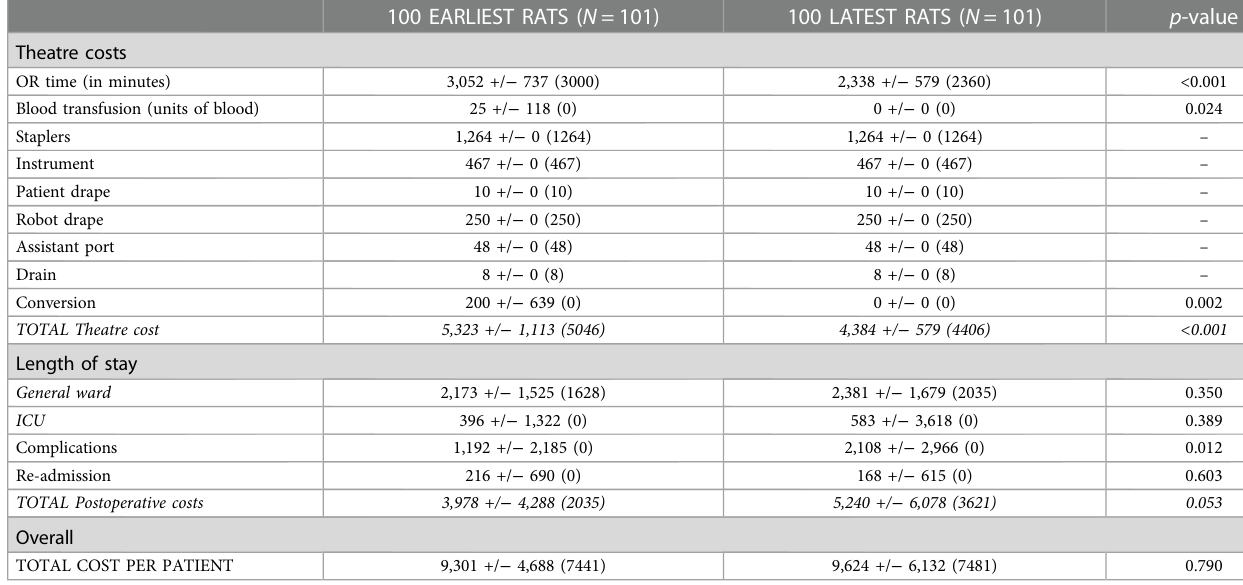
TABLE 3 Analysis of cost related to the learning curve. Mean±standard deviation (median) per patient. All costs in £GBP. OR: Operating